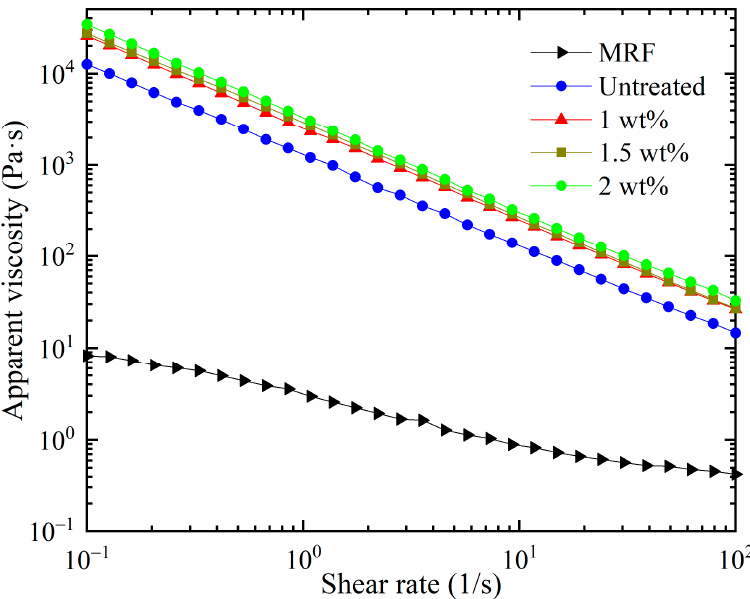
Figure 4. Variation of viscosity with shear rate under zero-field.